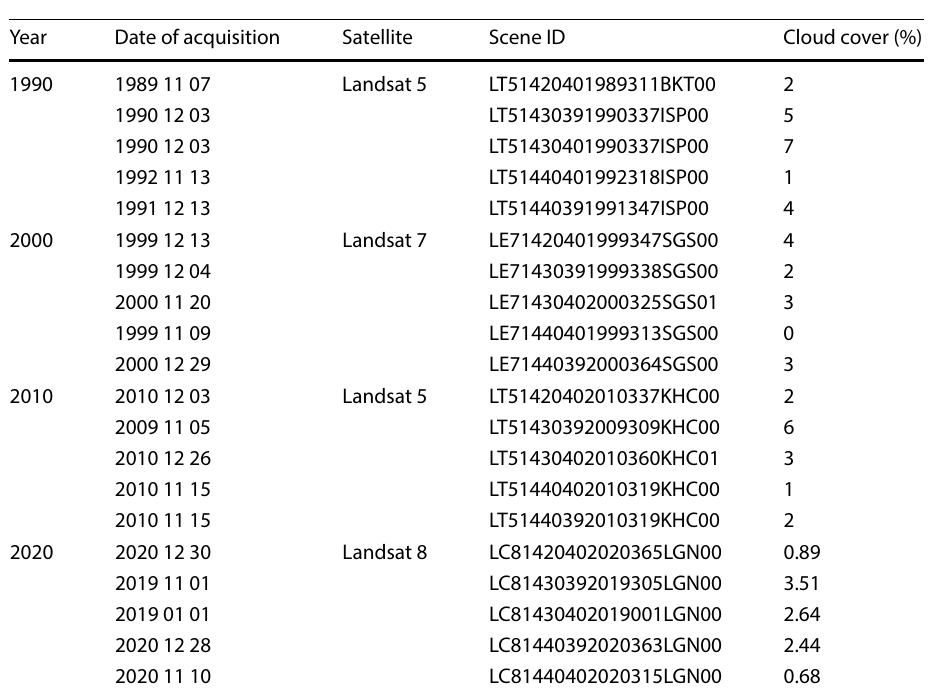
Table 1 Landsat images used for the